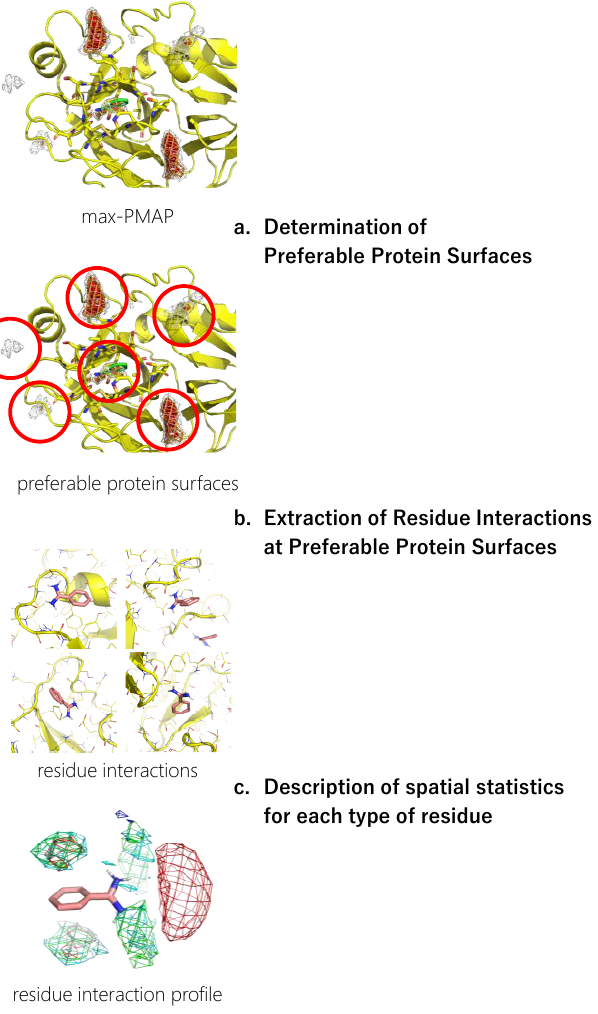
Figure 1. A workflow of inverse MSMD to construct a residue interaction profile.